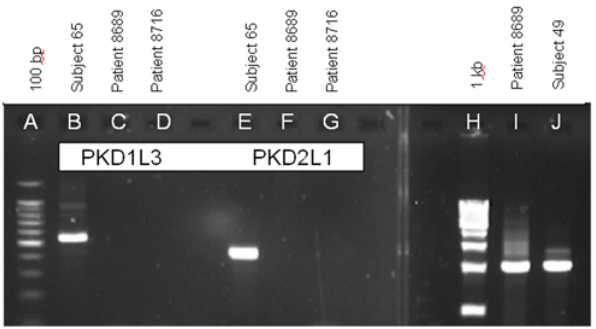
Figure 2. RT-PCR and genomic analysis of polycystic kidney disease (PKD) gene expression in sour-ageusic patients and sour-normal subjects. Sour-ageusic patients do not express detect- able transcripts for either PKD1L3 or PKD2L1, even after 50 cycles of amplification, and for PKD2L1 this is not the result of a loss of the PKD2L1 gene. Sour-normal subjects express both transcripts. Lane identifications: (A) 100 bp DNA marker with the brightest band being 500 bp; (B–D) Transcript for PKD1L3 in, respectively, sour-normal Subject 65, sour-ageusic Patient 8689 and sour-ageusic Patient 8716; (E–G) Transcript for PKD2L1 in, respectively, sour-normal subject 65, sour-ageusic Patient 8689 and sour-ageusic Patient 8716; (H) 1 kb DNA marker; (I) genomic DNA of Patient 8689 amplified with primer pair HPKD2F1 and HPKD2R1 (see Table 1); (J) RT-PCR for full coding sequence of PKD2L1 of sour-normal Subject 49. RT-PCR was performed with cDNA from fungiform papillae (B–G and J) , but only the data for the tubes containing reverse transcriptase are presented. No products were detected in the tubes lacking reverse transcriptase. Genomic analysis (I) was performed using buccal tissue from Patient 8689. Patient 8716 did not provide buccal tissue. Individual amplification reactions were performed for each named molecular target and the data are shown in collated form. Identities of all amplification products were confirmed by